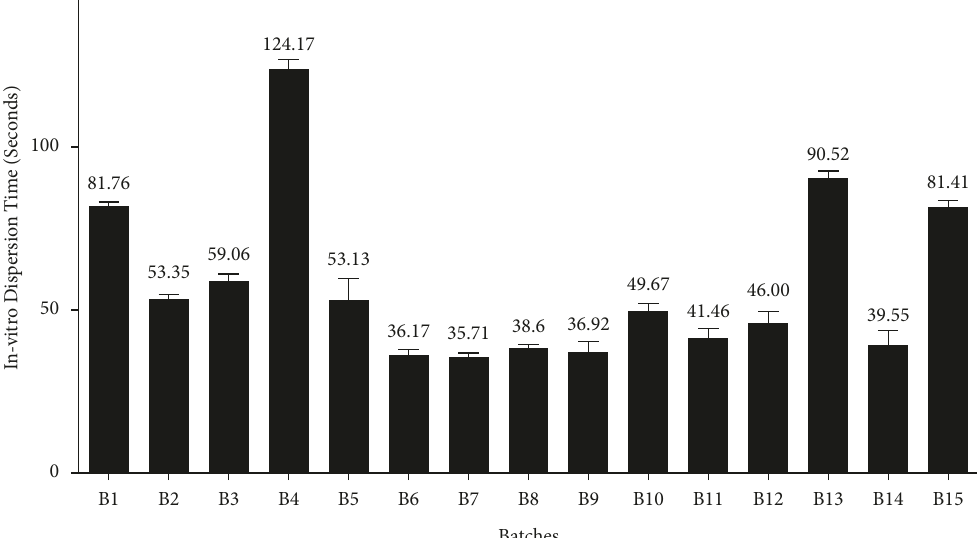
Figure 6: Bar diagram for the measurement of in vitro dispersion time (in seconds) for different